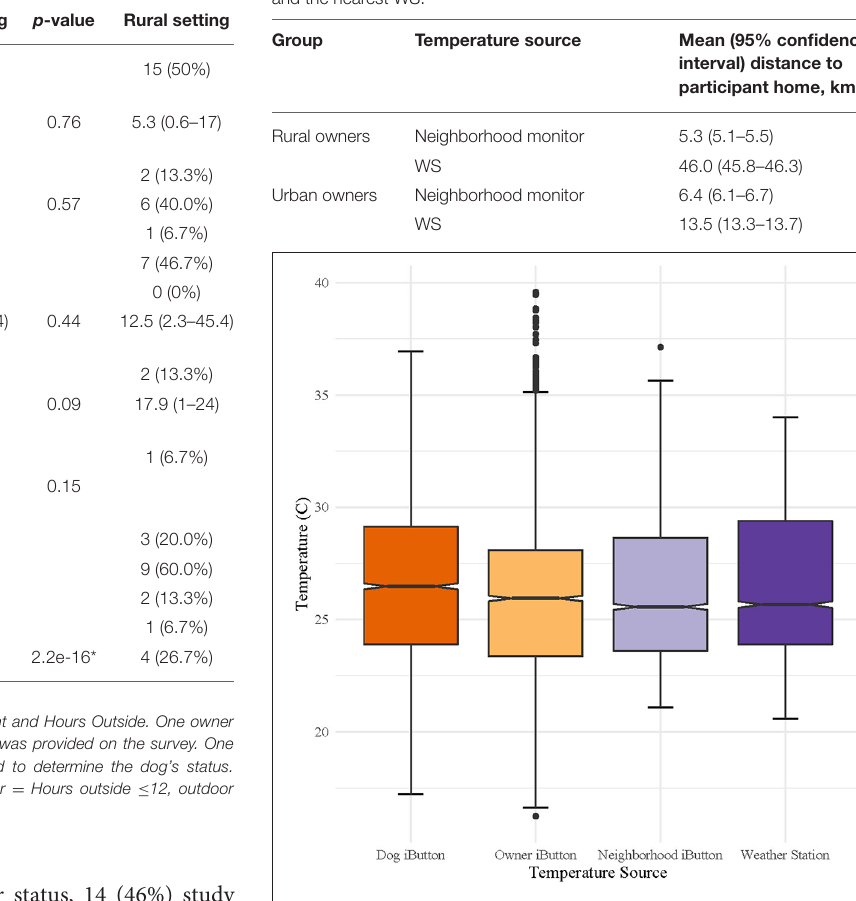
FIGURE 1 | Median and range of temperatures measured on canine pets, their owners, neighborhood thermometers, and the nearest weather station. Canine pet and owner data were collected over 6-day period for each dog, with staggered enrollment over a 10-day period in July 2017, using wearable iButton ® thermometers. Neighborhood ambient temperatures were captured using shielded iButton ® thermometers/hygrometers placed in neighborhoods and weather station data was downloaded from the National Weather Service weather station data archive.